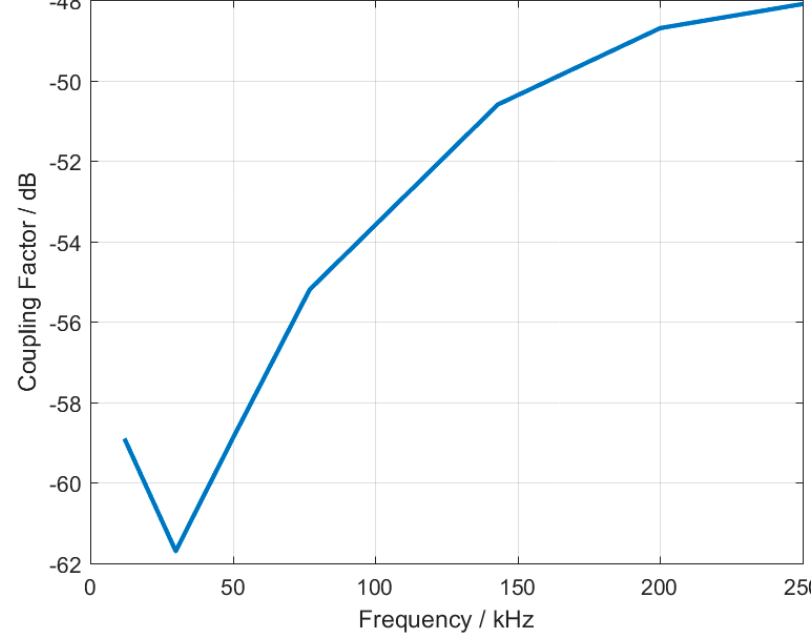
Figure 9. Coupling between the current sources over frequency.